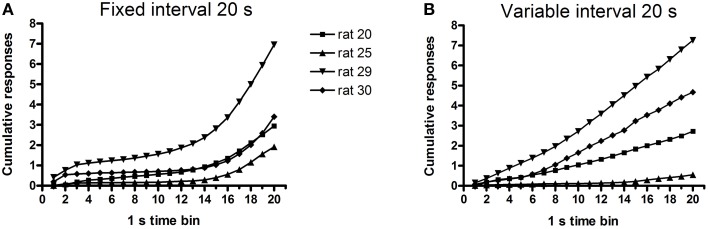
Cumulative lever responses for each rat (n = 4) as a function of time since the last optogenetic stimulation. (A) shows lever responses increasing as the next stimulation opportunity approached (at 20 s). (B) shows lever pressing at a near-constant rate during the 10 s prior to the onset of the next stimulation opportunity (times randomly selected from lagged exponential distribution with mean 20 s).